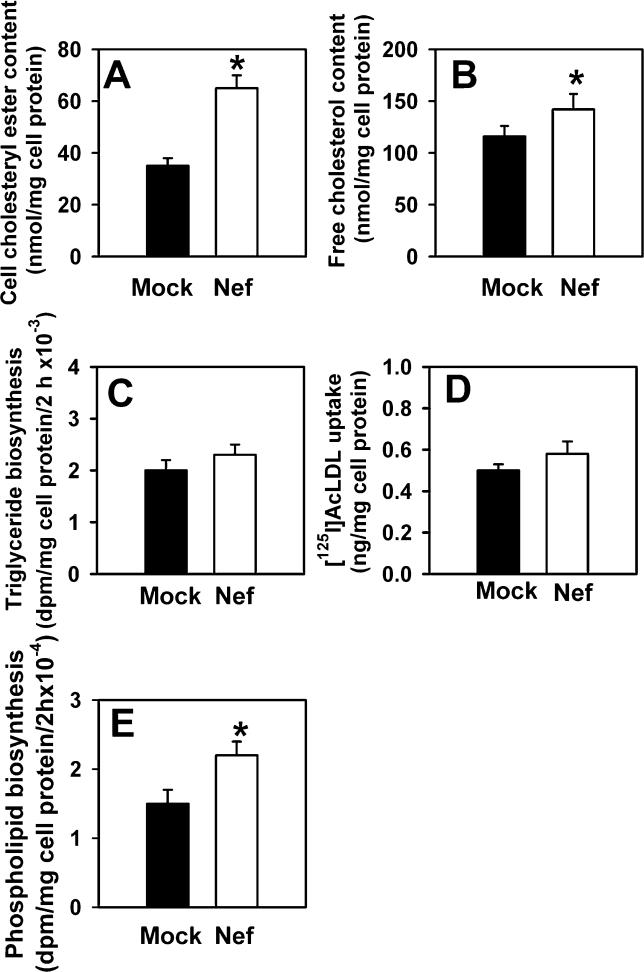
Analysis of Lipids in RAW 264.7 Macrophages Transfected with Nef(A) Cholesteryl ester content after 24 h incubation with AcLDL (50 μg/ml) determined by enzymatic assay; an asterisk (*) indicates p < 0.01.(B) Free cholesterol content after 24 h incubation with AcLDL (50 μg/ml) determined by enzymatic assay; an asterisk (*) indicates p < 0.05.(C) Triglyceride biosynthesis after 24 h incubation with AcLDL (50 μg/ml) measured as incorporation of [14C]oleic acid into triglycerides as described in Materials and Methods.(D) Uptake of AcLDL was calculated as a sum of 125I-AcLDL specifically taken up and degraded by cells.(E) Phospholipid biosynthesis measured as incorporation of [14C]choline into phospholipid fraction as described in Materials and Methods; an asterisk (*) indicates p < 0.01.